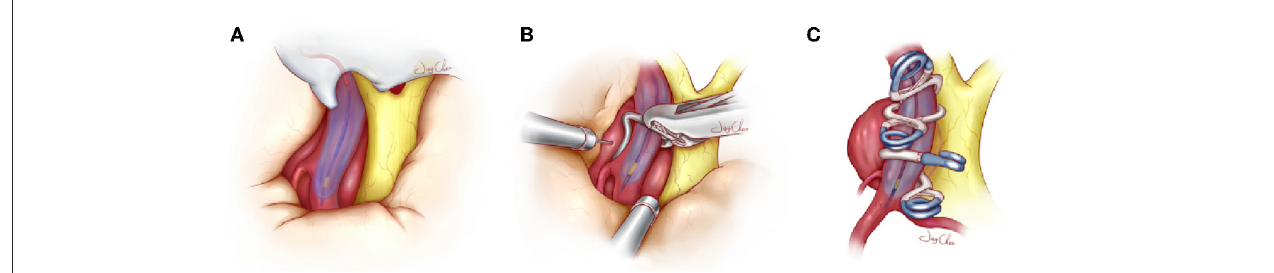
FIGURE1 Schematic diagram about the visualization balloon occlusion-assisted technique used to treat large and giant paraclinoid aneurysms. (A) The balloon is successfully navigated across the neck of the aneurysm and inflated by a contrast agent diluted with methylene blue, which is identified under the microscope. (B) Once the balloon is inflated with the aid of microscopic visualization and the blood supply of the aneurysm has been completely blocked, the dome of the aneurysm is punctured or cut to release the remaining hematoma or thrombus. When the aneurysm collapses, the clots and plaques in the cavity are further removed, which facilitates accurate clip placement. (C) Accurate tandem clipping is performed with fenestrated clips or straight clips with the aid of the inflated balloon, which provides tactile and visual feedback to the surgeon. During clip closure, the surgeon can distinguish the vessel lumen and contiguous perforating branches from the longitudinal visualization balloon, and this helps to preserve the true lumen of the parent vessel and collateral blood vessels. Once the complete exclusion is confirmed, the deflated balloon and guide catheter are